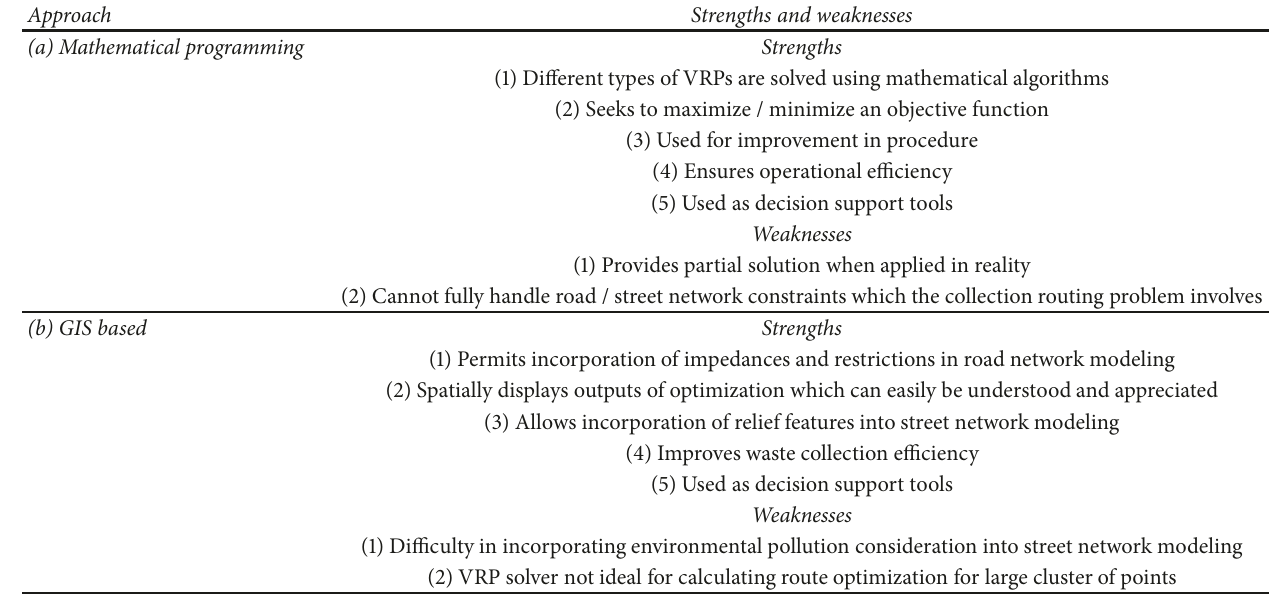
Table 4: Summary of solid waste collection optimization